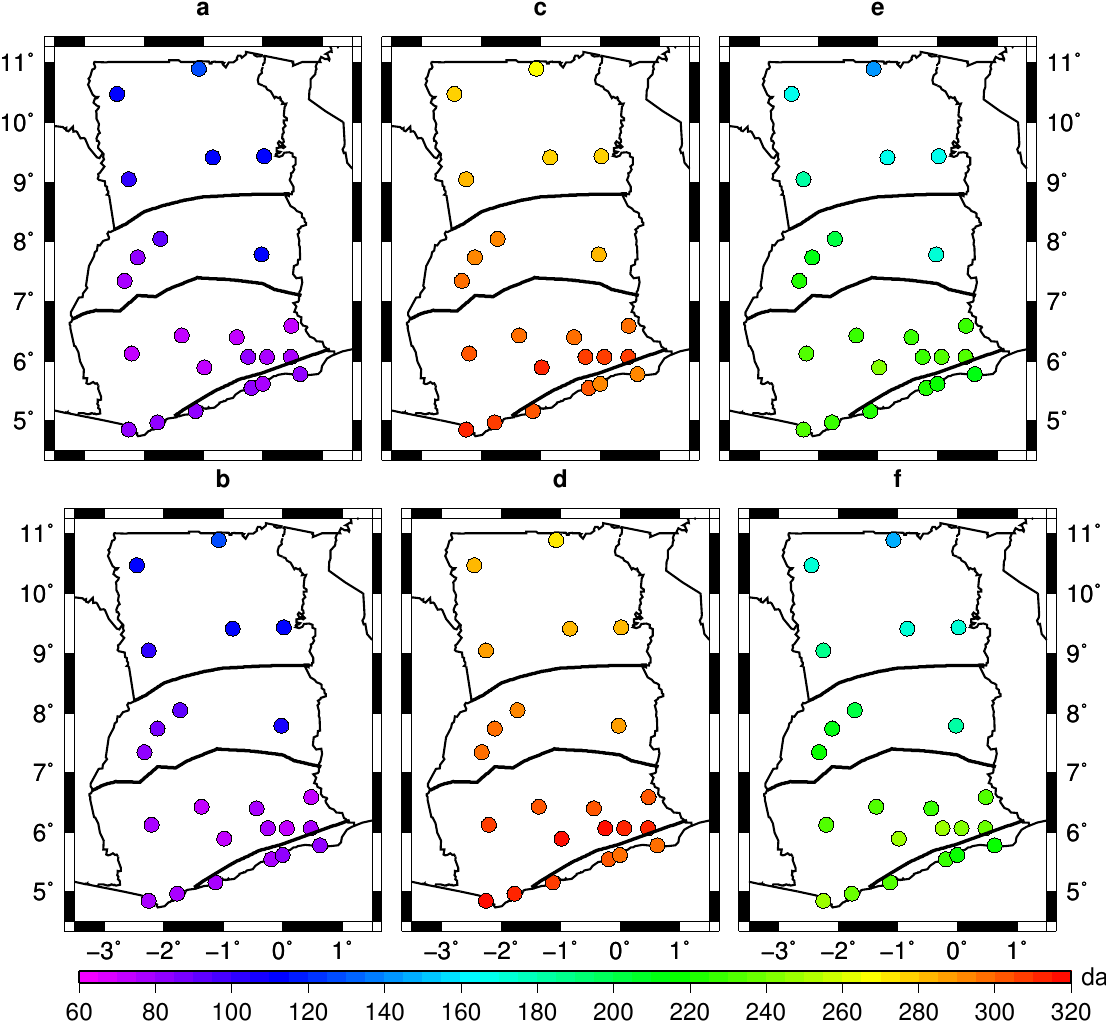
Figure 3. Map of rainfall onset days, cessation days and the length of the rainy season for the 23 GMet stations in Ghana. ( a ) Onset days using rainfall amount; ( b ) onset days using number of rainy days; ( c ) cessation days using rainfall amount; and ( d ) cessation days using number of rainy days. ( e , f ) The length of the rainy season using rainfall amount and the number of rainy days,